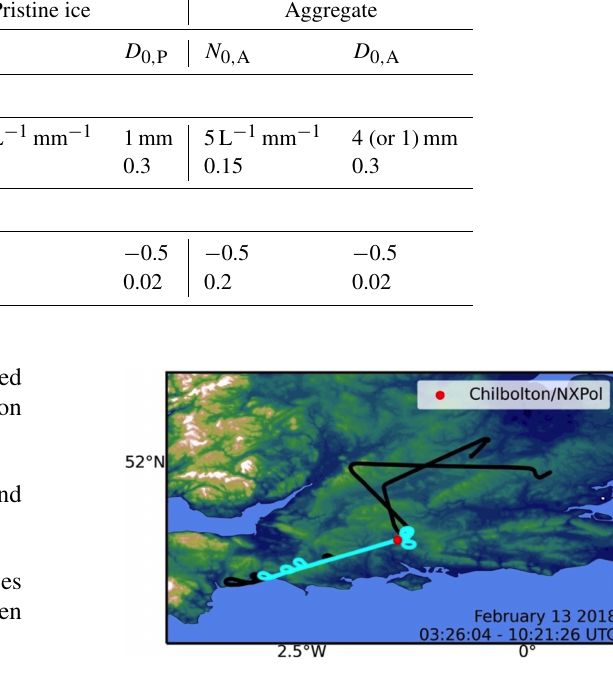
Figure 3. Flight paths on 13 February 2018 between 03:26 and 10:21UTC. The red dot denotes the location of NXPol in Chilbolton, UK, while the path in cyan denotes the path during 06:00–09:00UTC in which retrievals are evaluated in Sect.